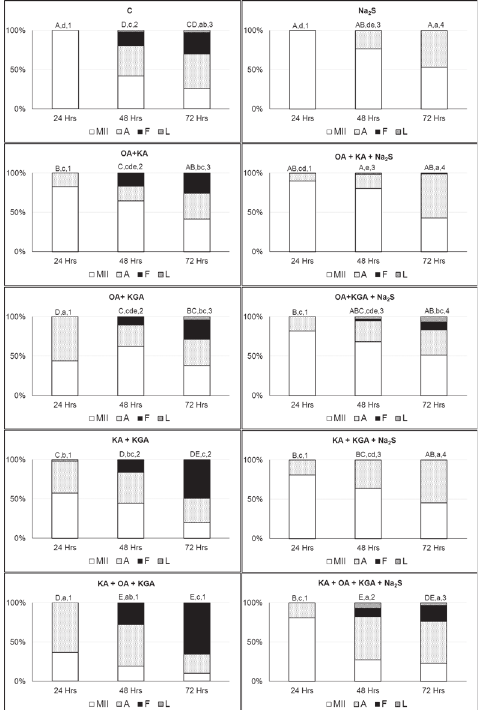
Figure 5. Effects of concurrent CBS, CSE and MPST inhibition and its reversion using a H 2 S donor. Oocytes were cultivated to metaphase II and then exposed to prolonged cultivation in a modified M199 medium supplemented with a H 2 S donor (Na 2 S.9H 2 O; 300 μ M) and the inhibitors for 24, 48 and 72 hours. Various combinations of oxamic acid (1mM, OA) which was used as a CBS inhibitor, beta-kyano-L-alanine (1mM, KA) which was used as a CSE inhibitor and alpha-ketoglutaric acid disodium salt dihydrate (5mM, KGA) which was used as a MPST inhibitor were used in this experiment. To reverse effects of inhibitors, a H 2 S donor (300 μ M, Na 2 S.9H 2 O) was added to each experimental group. C- control; Na 2 S (300 μ M,